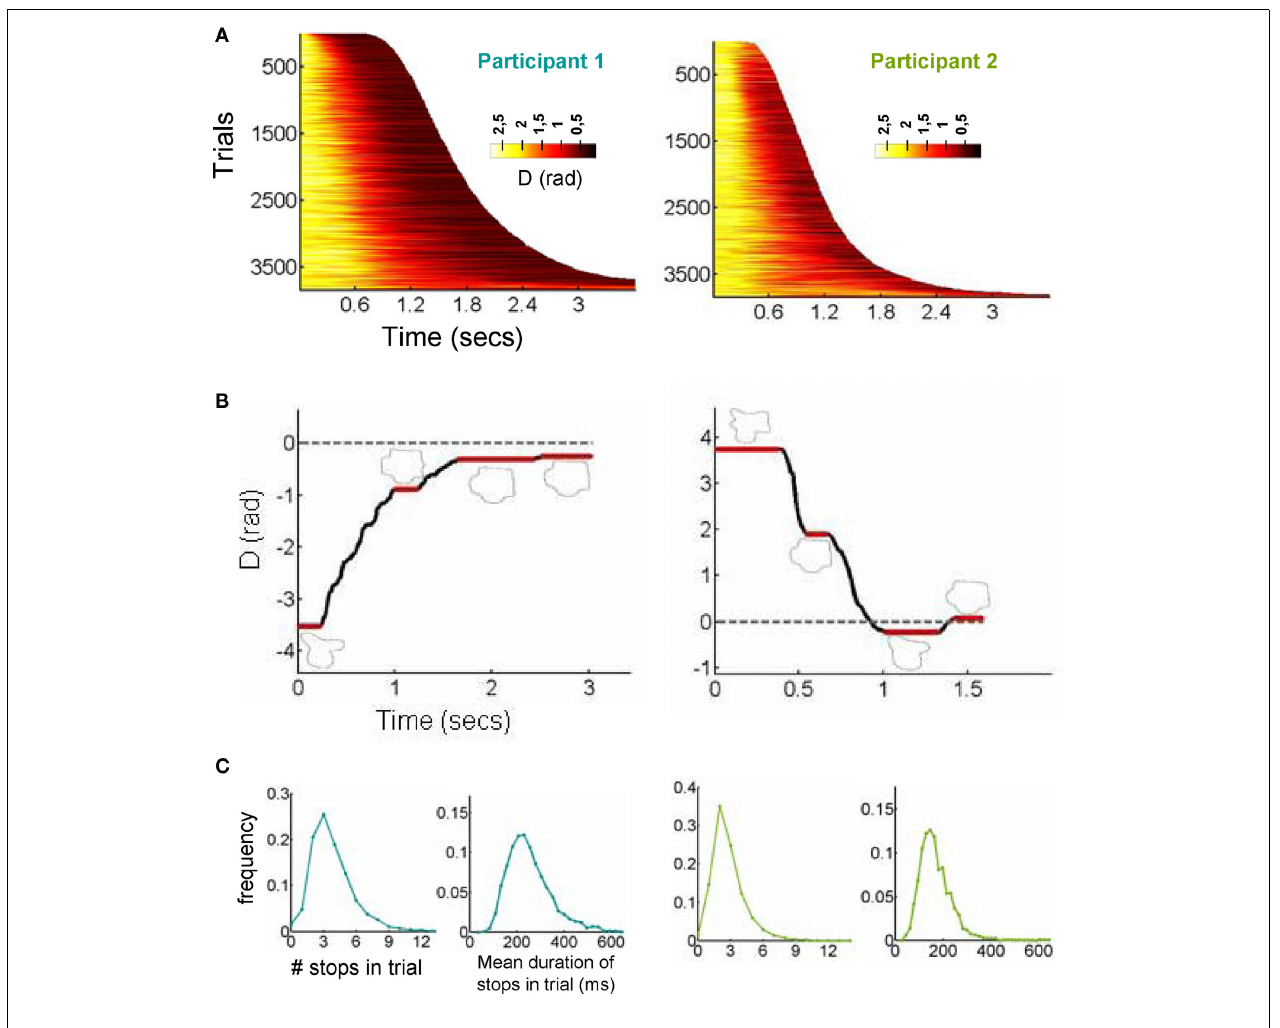
participant does not move the mouse) which were observed in all trajectories. Sampling points with a distance greater than pi relates to the existence of a complete turn in the trajectory. (C) Histograms of number of stops per trajectory and stop duration. Stops were relatively fast (on average about 200ms) and were unnoticed to